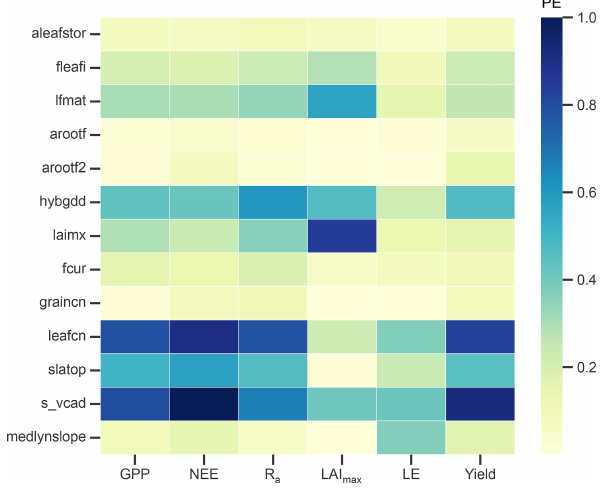
Figure 3. Parameter effect (PE) as a measure of sensitivity of selected output variables to the most influential model parame- ters. Output variables include gross primary production (GPP), net ecosystem exchange (NEE), autotrophic respiration ( R a ), maximum leaf area index (LAI max ), latent heat flux (LE), and yield. Parame- ters are post-harvest leaf allocation coefficient to storage ( aleafstor ), initial leaf allocation coefficient ( fleafi ), GDD to canopy maturity ( lfmat ), root allocation coefficients at the start of fruit development ( arootf ) and until harvest ( arootf2 ), GDD needed until harvest ( hy- bgdd ), maximum LAI ( laimx ), fraction of allocation that goes to currently displayed growth ( fcur ), C : N ratios of fruits ( graincn ) and leaves ( leafcn ), specific leaf area at top of canopy ( slatop ), slope of the relationship between leaf N per unit area and the maximum rate of carboxylation at 25 ◦ C ( s_vcad ), and the medlyn slope of the conductance–photosynthesis relationship ( medlynslope ). For more details on the parameters, see Appendix